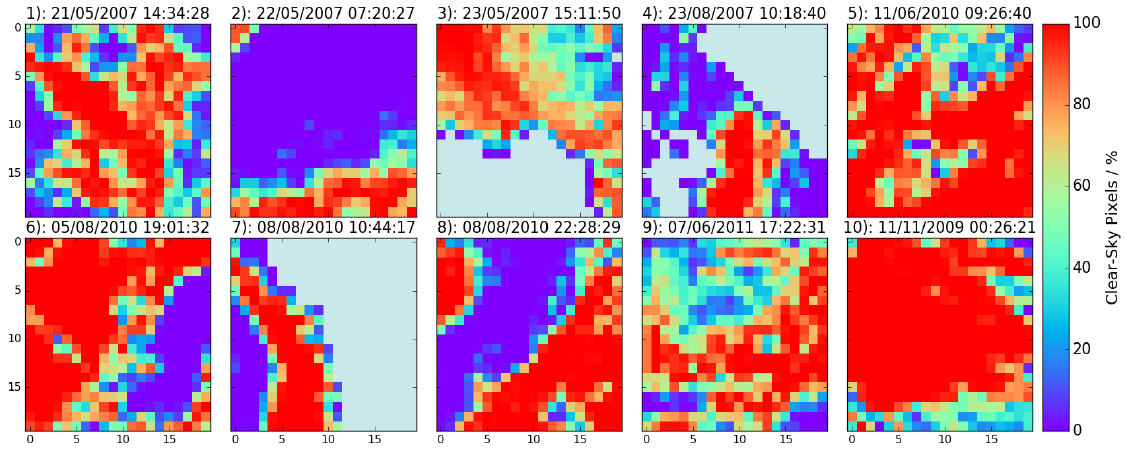
Figure 6. Clear-sky fraction for the 10 submission scenes in the cloud clearing inter-comparison (Table 1) at 625-km 2 resolution. Individual plot headings give the scene number, date and orbit start